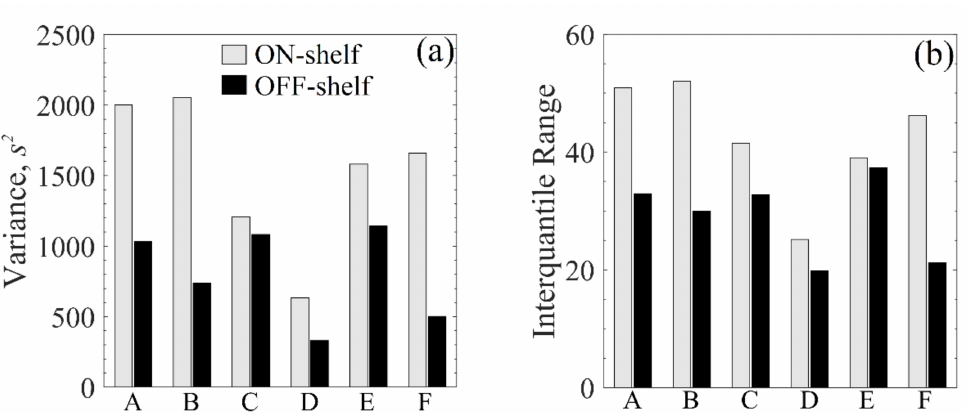
Figure 8. Variance ( a ) and Interquartile range ( b ) of the resulting pore size distribution for all VISF tests. In both bar plots, A, B and C are tests at 271 K while D, E and F are tests at 263 K. The solutions used are 5% sucrose (A,D), 5% mannitol (B,E) and 10% dextran